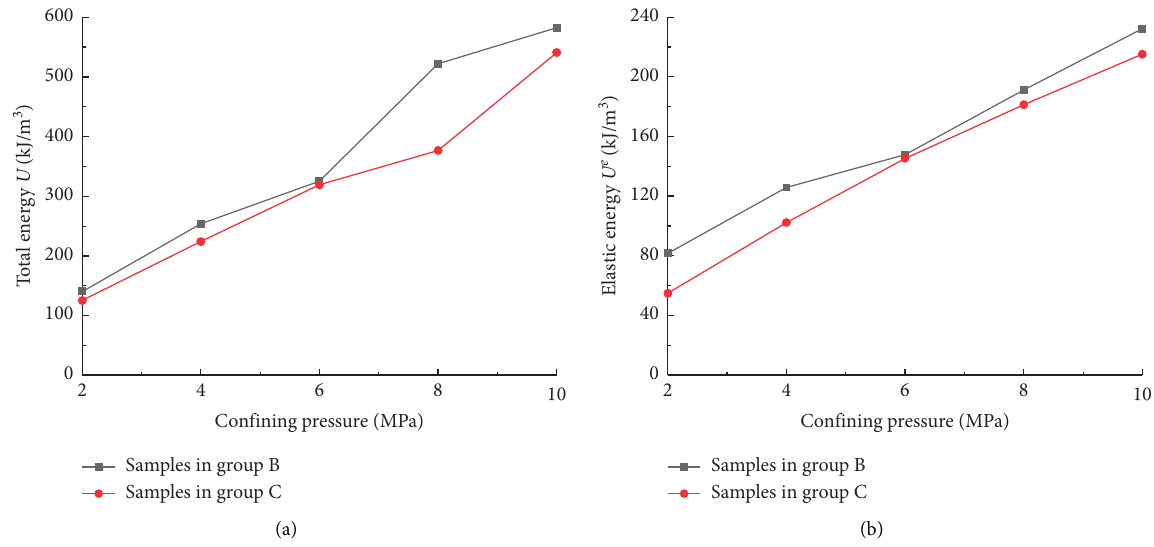
Figure 8: Curves of total energy and elastic energy of group B and group C samples changing with confining pressure at the peak stress point. Table 3: Geometric dimensions of the K-block.